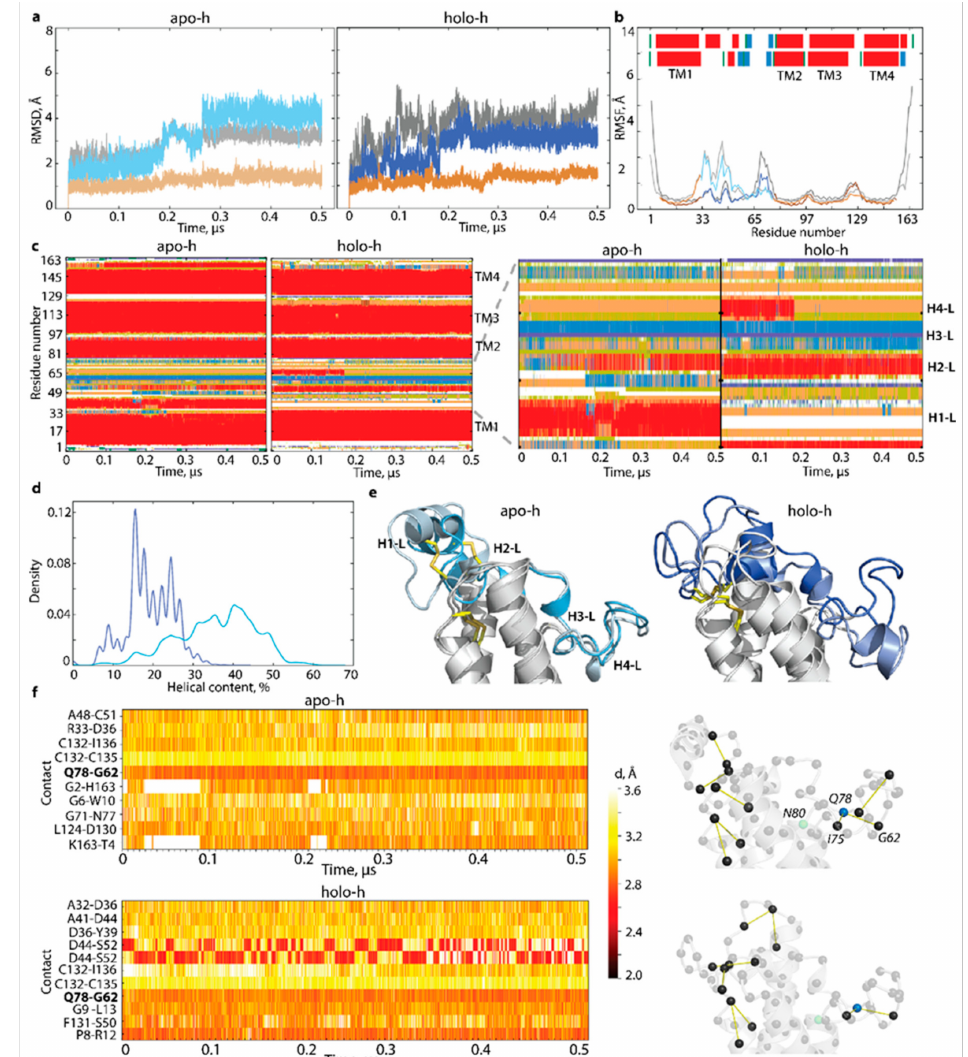
Figure 4. Accelerated MD simulations (GaMD) of human VKORC1 homology models, derived from crystallographic structures. ( a ) RMSDs computed for C α -atoms of the full-length protein, TMD, and L-loop after fitting on the initial conformation (t = 0 ns) of the related domain. ( b ) RMSFs computed for the C α atoms of two forms GaMD conformations after fitting on the respective average conformations. ( a , b ) Apo-h and holo-h forms are in light and dark colours, respectively: L-loop in blue, TMD in brown, total hVKORC1 in grey. ( c ) Time-dependent evolution of each residue secondary structures as assigned by DSSP method for L-loop: α -helices are in red, 3 10 -helices in blue, turn in orange, and bend in dark yellow. ( d ) Helical content of each form. ( e ) Superimposition of hVKORC1 conformations picked at 0 and 500 ns. Protein is shown as cartoon with disulfide bridges-forming cysteine residues in yellow sticks. TMD helices are in grey; L-loop conformations are distinguished by colour: t = 0 and 500 ns are in grey and blue for apo and dark blue and violet for holo-c form. ( f ) (Left) Non-covalent contacts (time series of H-bond events for H-bonds observed with frequency ≥ 0.8) in two forms of the oxidised VKOR. The contacts strength is shown by colour, from the strongest (2.7 Å, in red) to the weakest (3.6 Å, in white). (Right) Graphs of non-covalent contacts zoomed in on L-loop. Vertices represent residues, and a link between two residues reflects